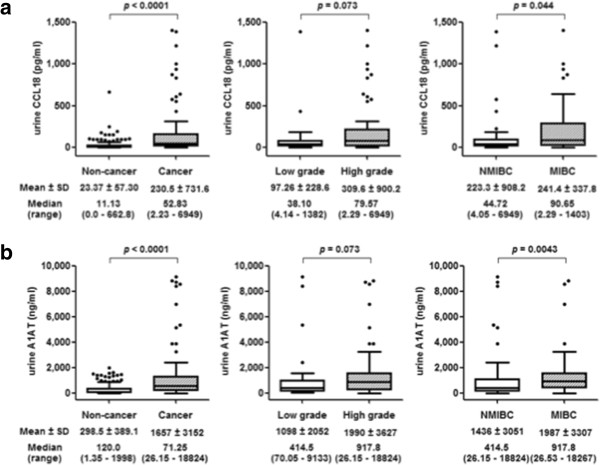
Urinary biomarker levels. a) Comparison of urine concentrations of CCL-18 between the cancer and non-cancer groups (left panel), low-grade and high-grade (middle panel) and non-muscle invasive bladder cancer (NMIBC) and muscle-invasive bladder cancer (MIBC). b) Comparison of urine concentrations of A1AT between the same groups. Median levels are depicted by horizontal lines within boxes, standard deviations are depicted by bars. Significance (p < 0.05) was assessed by the Wilcoxon rank sum test.